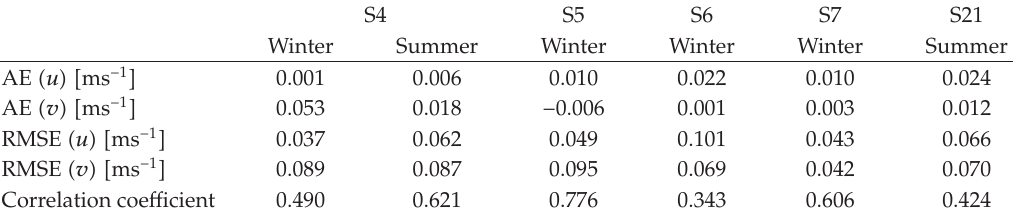
Table 2: Mean errors (cid:4) AEs (cid:5) and root mean squared errors (cid:4) RMSEs (cid:5) for modelled current components (cid:4) u,v (cid:5) with respect to the measured values, along with complex vector correlation coe ffi cients between measured and modelled